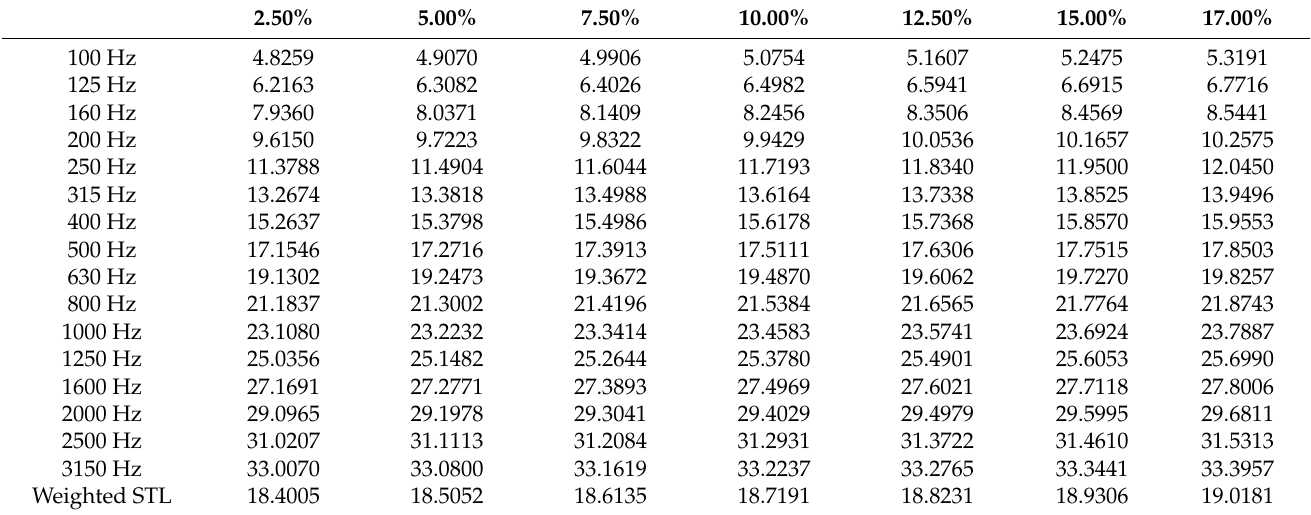
Table 4. The summarized STL data with the various volume ratio of the